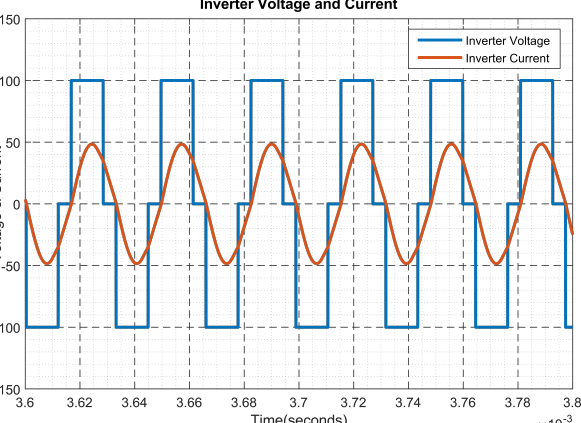
Figure 2. Output of inverter in Figure 1 in terms of voltage and current in optimum mode of